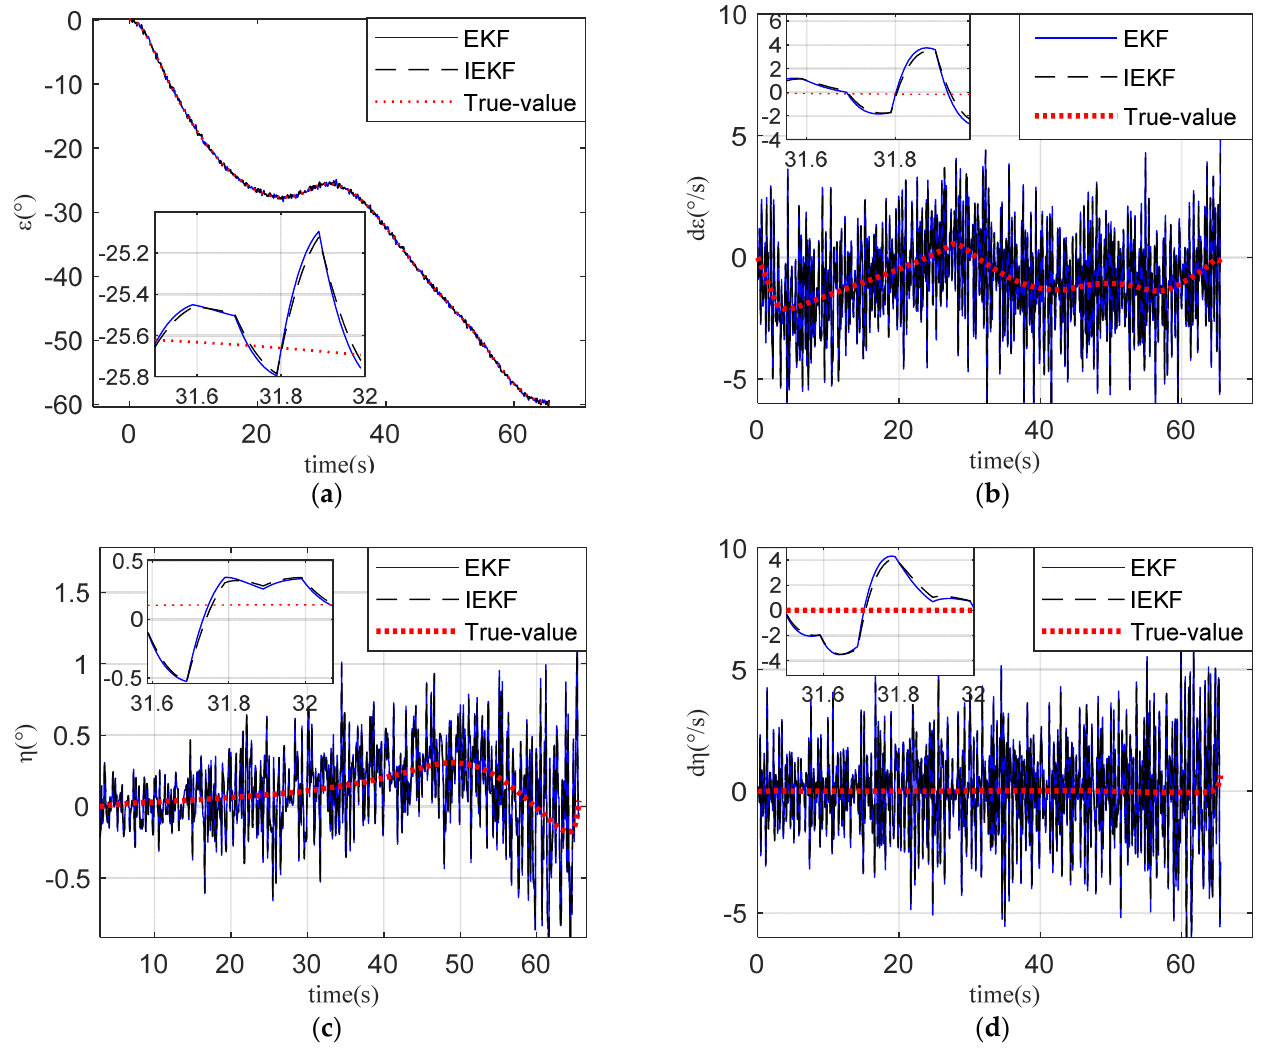
Figure 10. The results of EKF & IEKF. ( a ) Elevation of line-of-sight. ( b ) The rate of elevation of line-of-sight. ( c ) Azimuth of line-of-sight. ( d ) The rate of azimuth of line-of-sight.